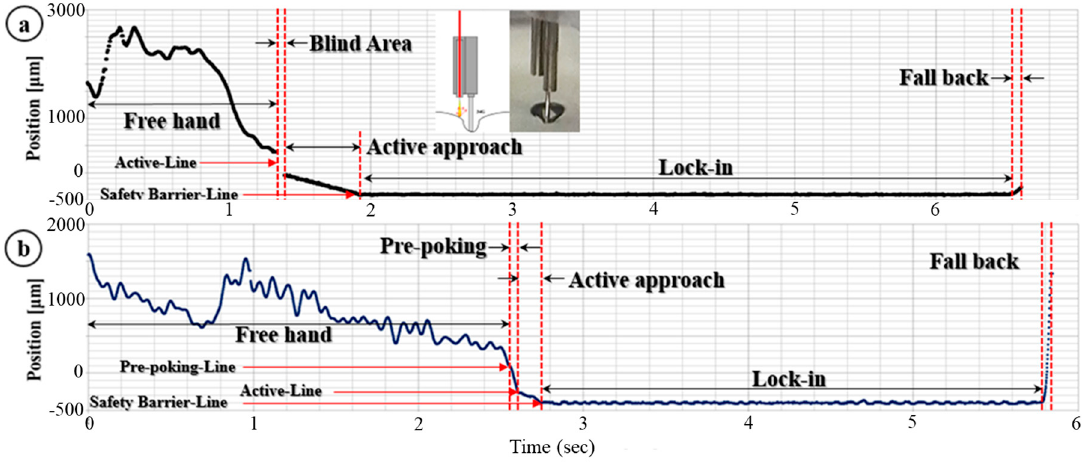
Figure 5. Needle-tip depth position graphs in one cycle of injection with different stages of needle guidance. The system engaged in the depth control once the needle tip was significantly close to the target defined by active line. In the lock-in stage, the depth position of the needle tip is fixed with the compensating motion by system and the effect of hand tremor and target motion is eliminated: ( a ) tracking data without prepoking stage and there is a blind area due to surface deformation of the sample, ( b ) tracking data with prepoking stage and the system achieves maximum speed during this stage to reduce the surface